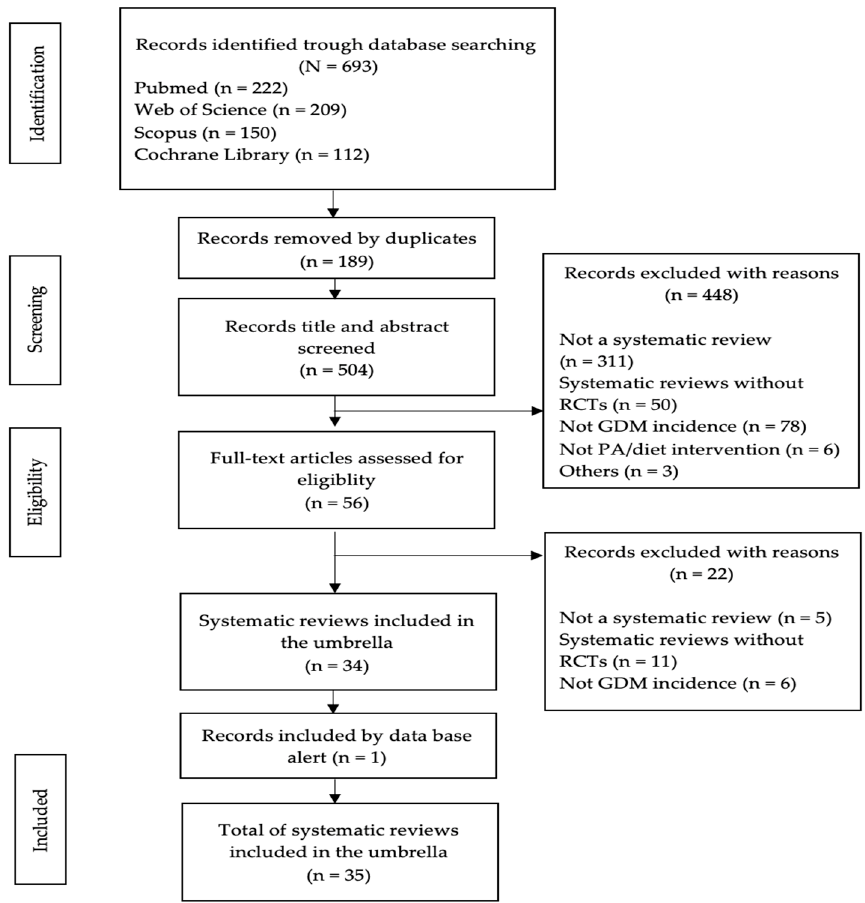
Figure 1. Flow chart: Systematic review selection process. RCTs: Randomized controlled trials; GDM: Gestational Diabetes Mellitus; and PA: Physical Activity.